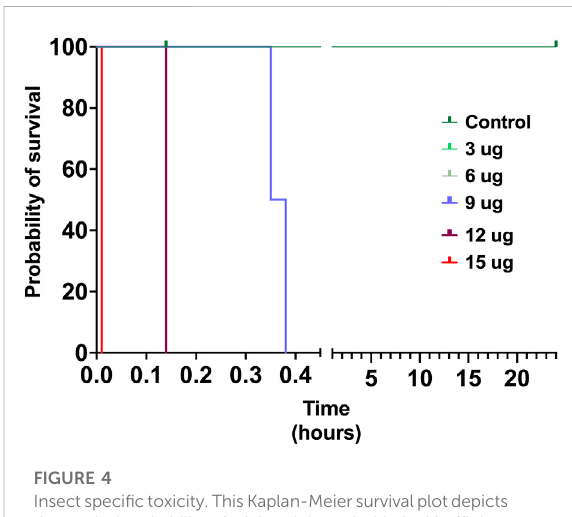
FIGURE 4 Insectspeci fi ctoxicity.ThisKaplan-Meiersurvivalplotdepicts thesurvivalprobabilityofcricketsinjectedwiththe V.af fi nis venom (2 per dose group), where the x-axis depicts the time in hours, and they-axis the probability of survival.Curves represent various doses of venoms administered into crickets. Experimental animals were monitored over a period of 24